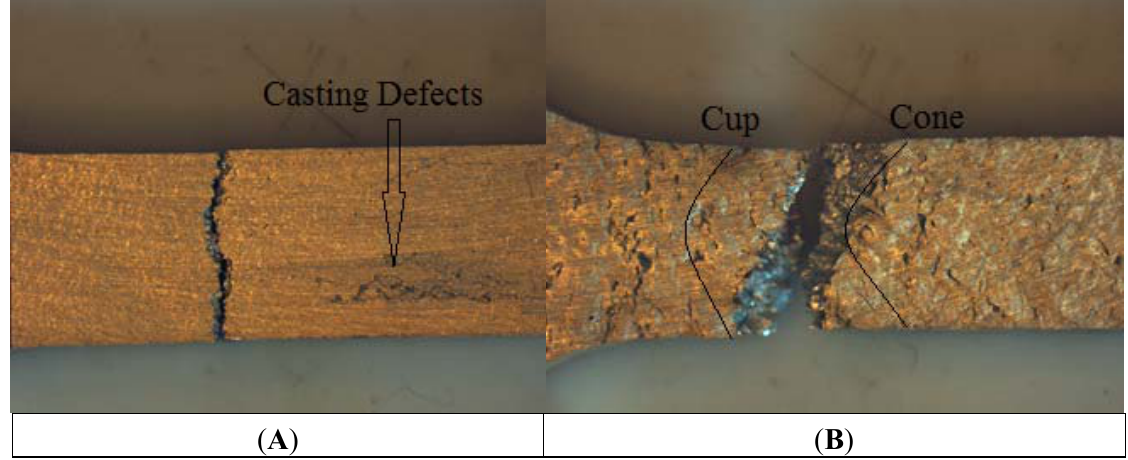
Figure 4. Optical images of tensile specimens after fracture. ( A ) Mg-Zn-Se alloy with transgranular brittle failure; ( B ) Mg-Zn-Cu alloy with intergranular failure with an average 13%